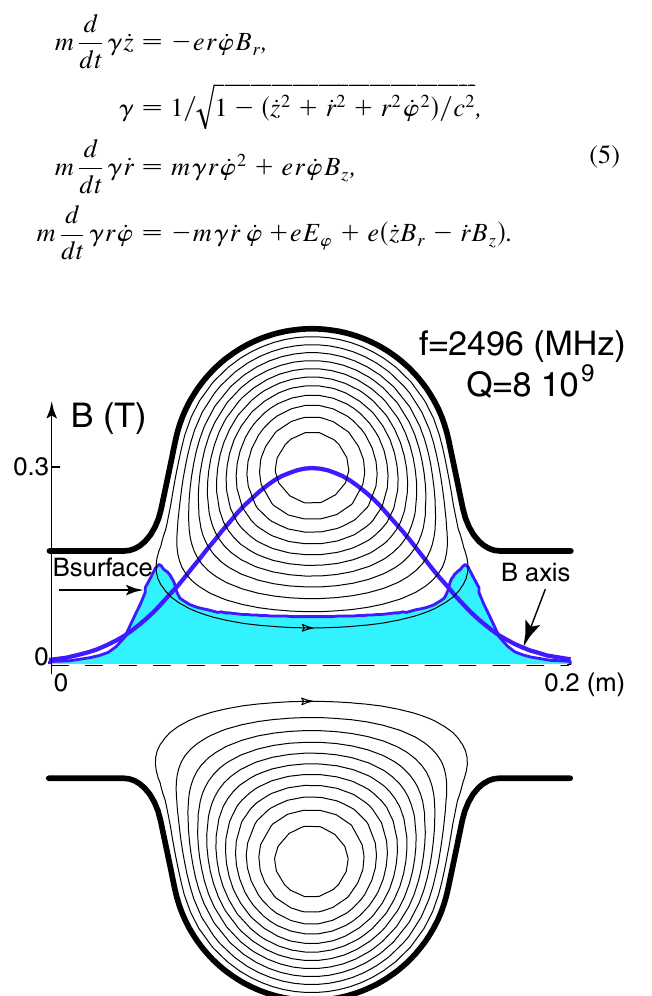
FIG. 1. (Color) Field pattern lines, axis, and surface field of the TESLA